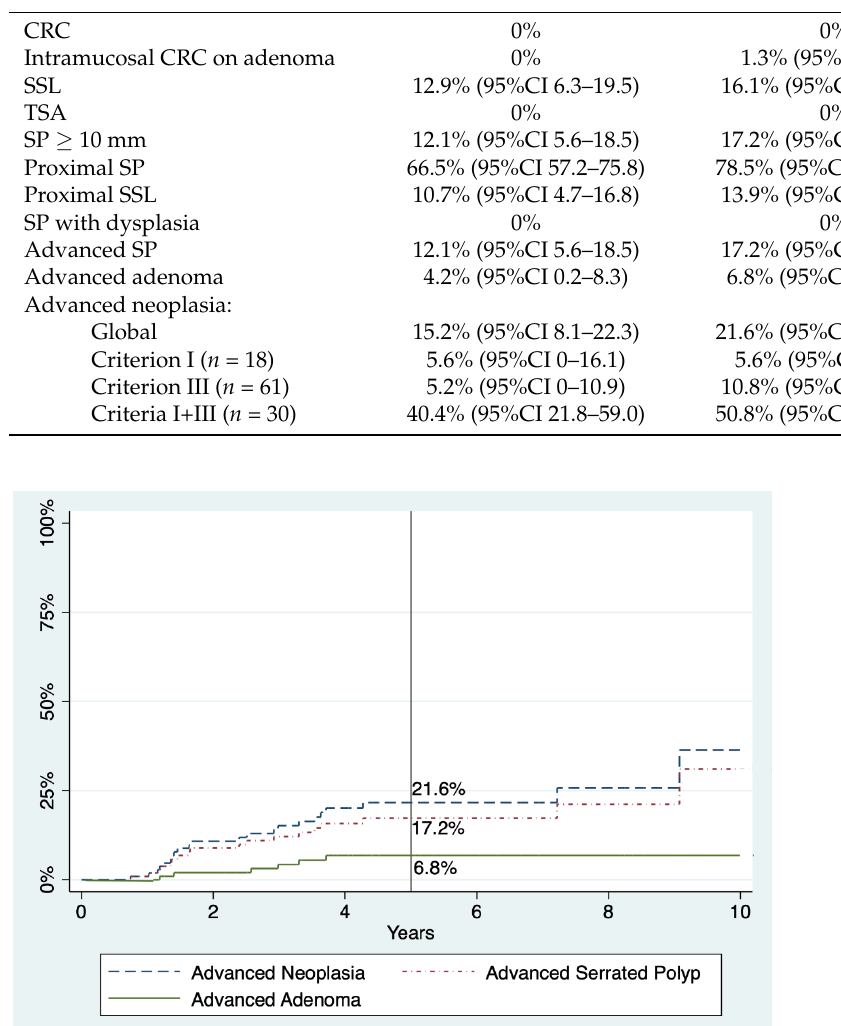
Figure 3. Cumulative incidences of advanced neoplasia within follow-up in patients with SPS, according to 2010 WHO criteria. Percentages refer to cumulative incidence at five years.